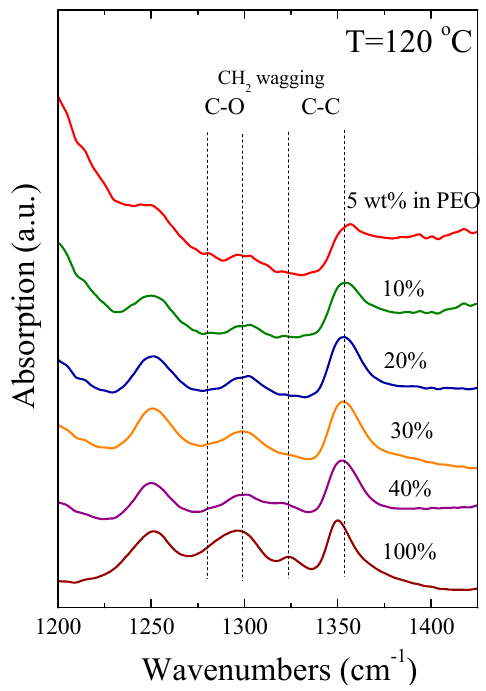
Figure 2. ATR-FTIR Spectra of pure PEO (bottom) and PEO/Na + -MMT nanocomposites with varying polymer content. The intensity of the peaks are normalized to the one at 1350 cm − 1 of the PEO whereas the curves have been shifted for clarity.